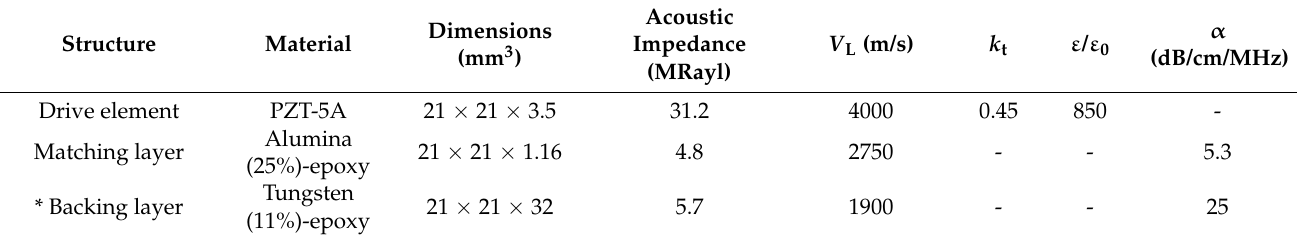
Table 1. Materials and dimensions of designed transducer parts. V L , k t , ε / ε 0 , and α denote longitu- dinal wave speed, thickness-mode coupling coefficient, dielectric constant along the thickness, and attenuation